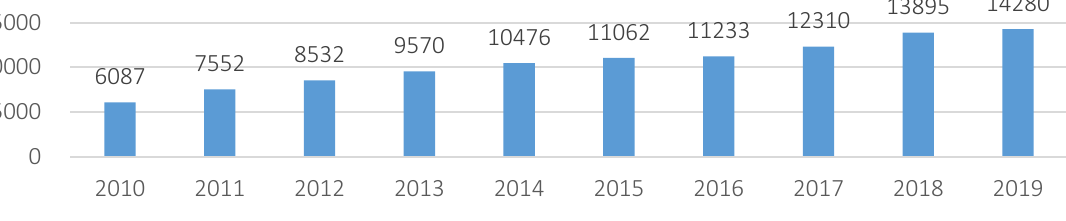
Figure 2. China’s GDP per year from 2010 to 2019